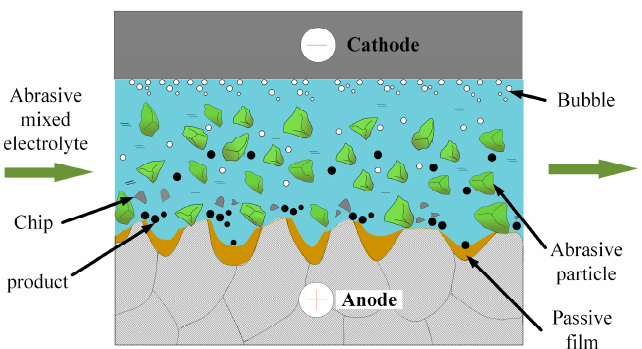
Figure 2. Polishing mechanism of proposed ECP method assisted by high-speed flow of micro-abrasive particles (ECFAP).